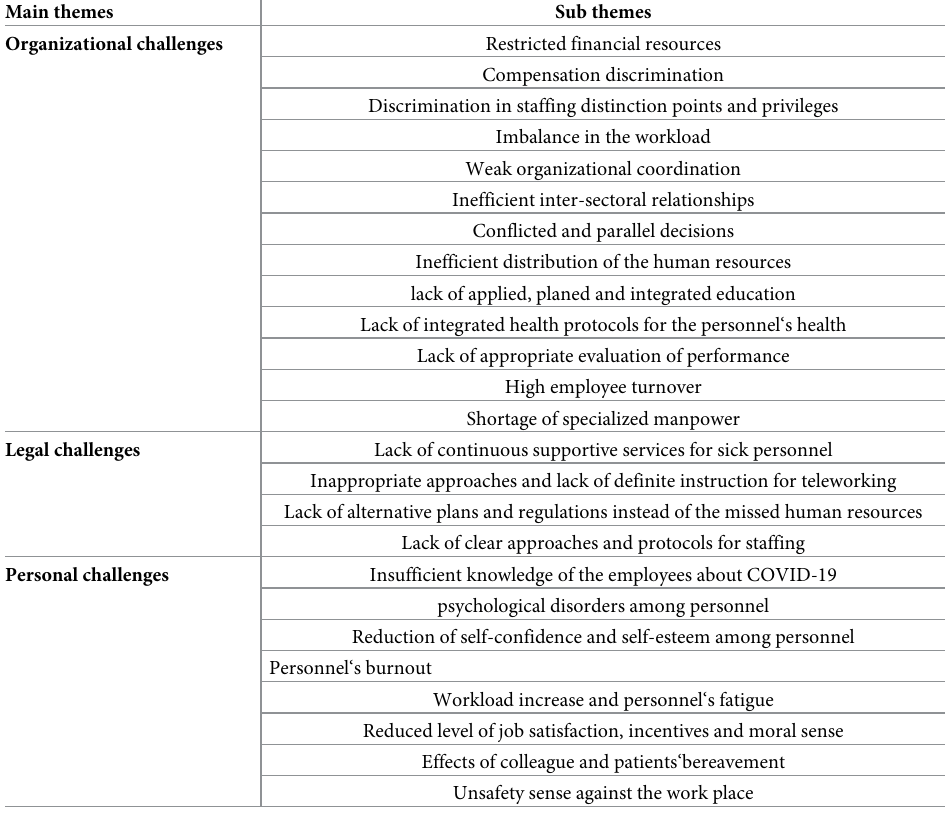
Table 2. The challenges of health human resources management during